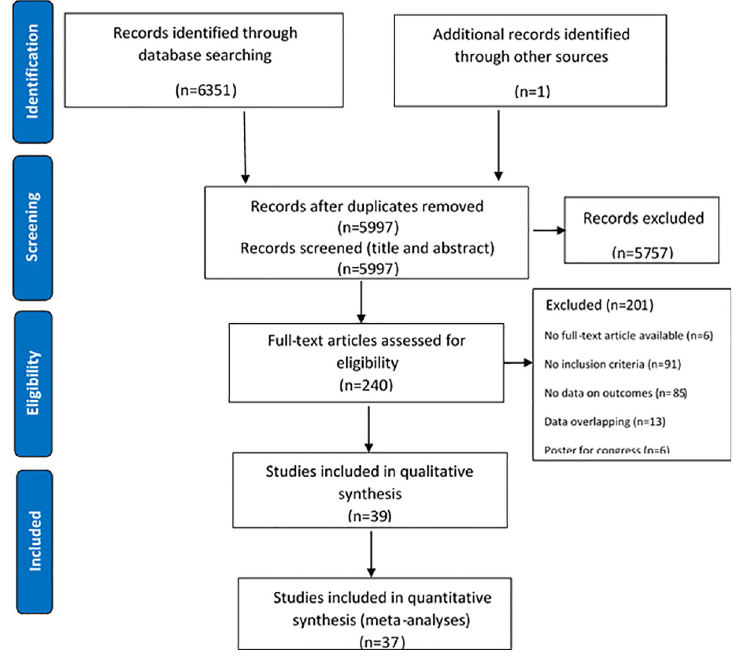
Fig 1. PRISMA flow diagram of selection of